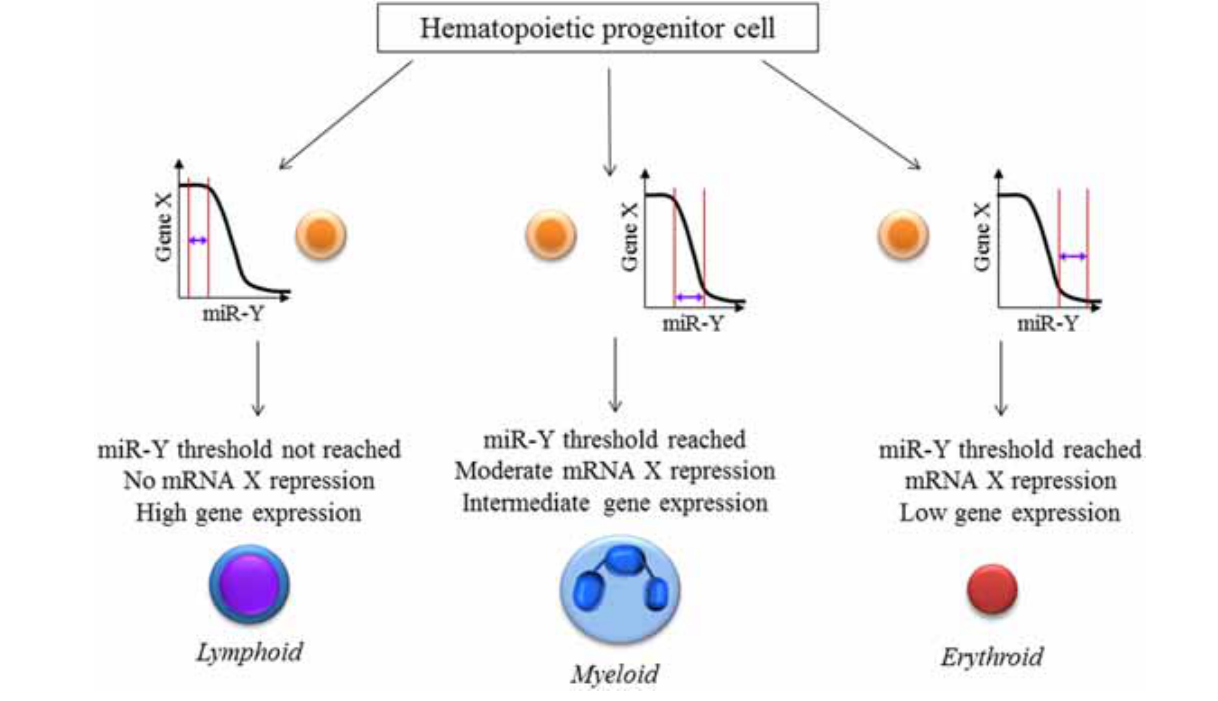
FIGURE 2 | miRNA:mRNA interaction-the threshold effect:The level of repression of gene expression is dependent on the levels of both the mRNA as well as the microRNA present inside a particular cell. This hypothetical figure assumes that the expression of mRNA X is important for hematopoietic cell lineage determination with high, intermediate and low